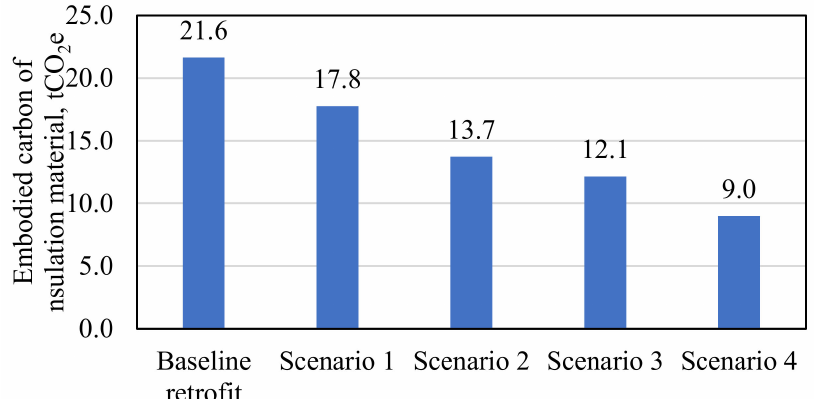
Figure 10. Carbon emission due to insulation material inputs in different retrofitting